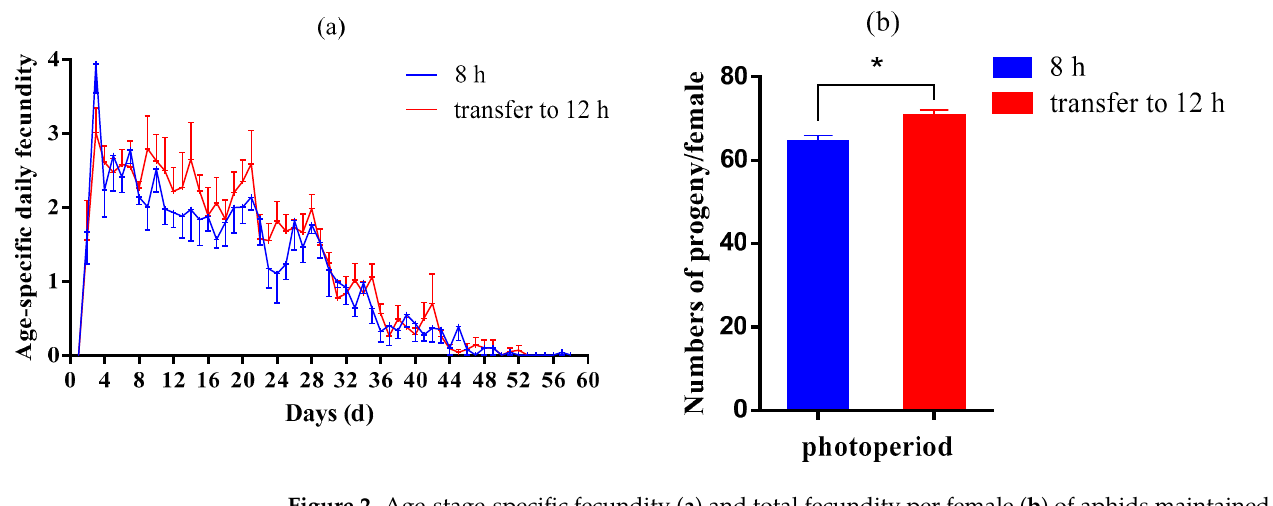
Figure 2. Age-stage-specific fecundity ( a ) and total fecundity per female ( b ) of aphids maintained under 8:16 light–dark cycles until the seventh generation and transferred to 12:12 light–dark cycles from the fifth generation. The results were represented as mean ± SE. * Indicates a significant difference between two photoperiods ( T -test; p < 0.05).